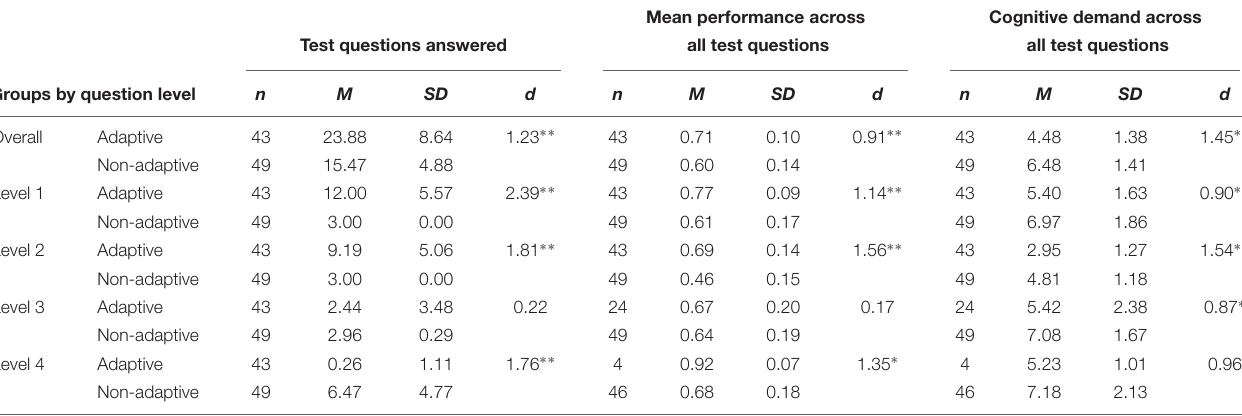
TABLE 2 | n , means, standard deviations, and effect sizes d for the number of test questions answered, mean performance across all test questions, and cognitive demand across all test questions by test question levels and testing